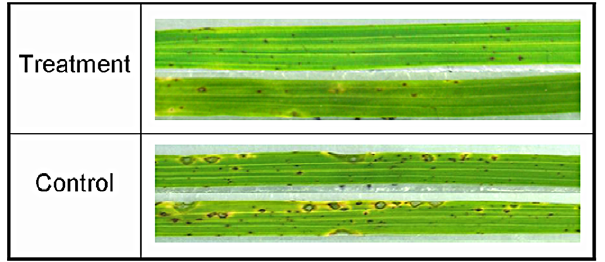
Figure 6. Representative disease symptoms on leaves of the MoHrip1-treated and control rice seedlings. Rice seedlings were sprayed with MoHrip1 (5 m M) or Mes-NaOH (20 mM) as a control 3 days before being treated with M. oryzae spores. The leaves of representative plants were photographed 7 days post-inoculation.